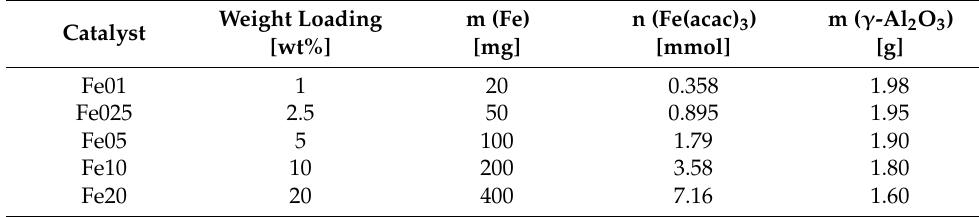
Table 7. Parameters for the catalyst preparation of Fe01 to Fe20.